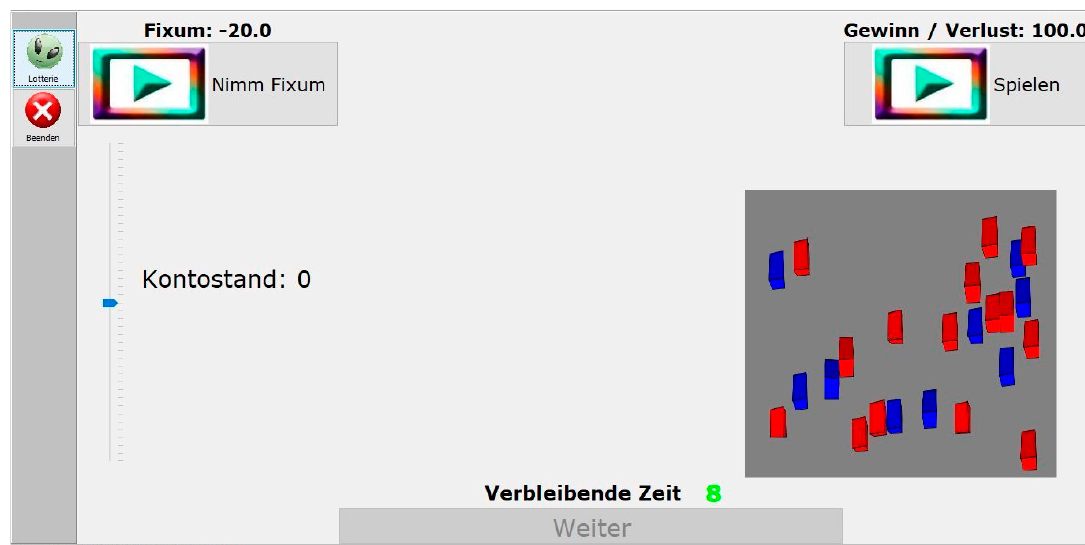
Figure 1. Probability-Associated Gambling Task (PAG) [59].